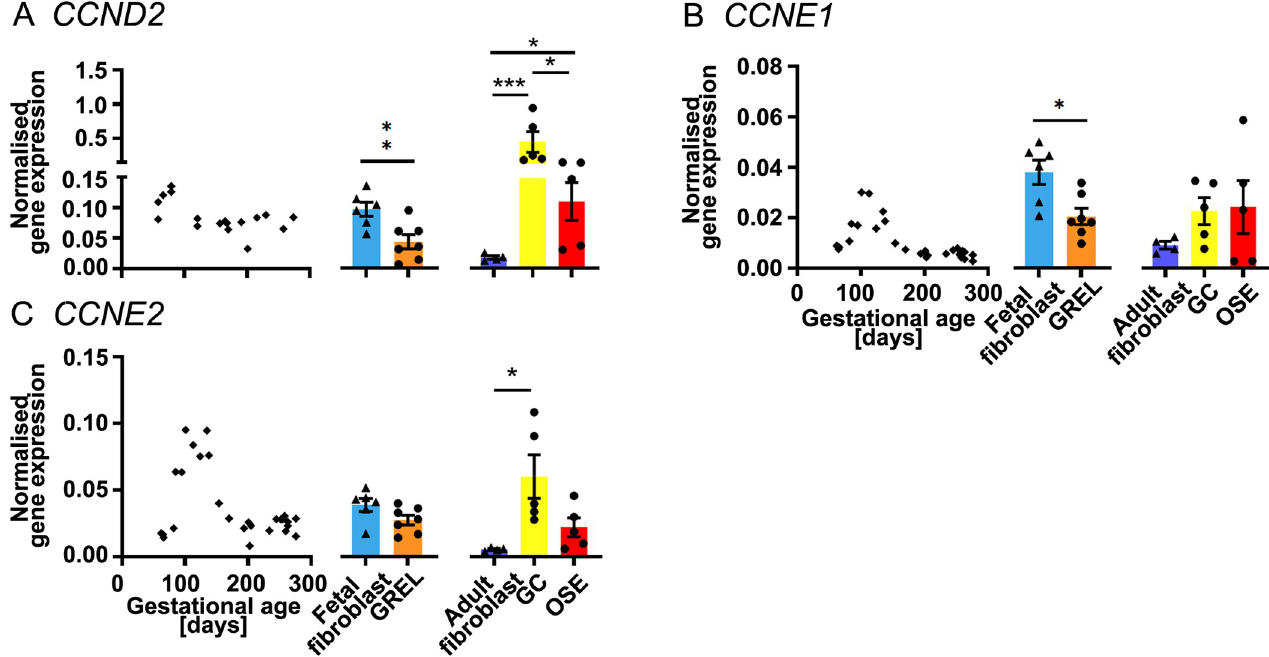
Fig 6. mRNA expression levels of cell cycle genes. Scatter plots in each subfigure show gene expression levels in fetal ovaries at different gestational ages (n = 27), and the scatter plot for CCND2 (A) is from our previous publication [31]. Gene expression levels in cultured GREL cells (n = 7; gestational ages are 51, 56, 73, 110, 110, 127 and 177 days) and fetal fibroblasts (n = 6; gestational ages are 51, 73, 101, 110, 110 and 177 days) are presented as mean ± SEM (normalised to PPIA and RPL32 ) in the middle graph of each subfigure. The differences between GREL cells and fetal fibroblasts were analysed with Student’s t-tests. Data of gene expression in adult fibroblasts (n = 4), granulosa cells (GC; n = 5) and ovarian surface epithelium (OSE; n = 5) are presented as mean ± SEM (normalised to PPIA and RPL32 ) in the graph on the right side of each subfigure. Significant differences among the three adult cell types were determined by one-way ANOVA with Tukey’s post-hoc test. � P < 0.05, �� P < 0.01, ��� P <